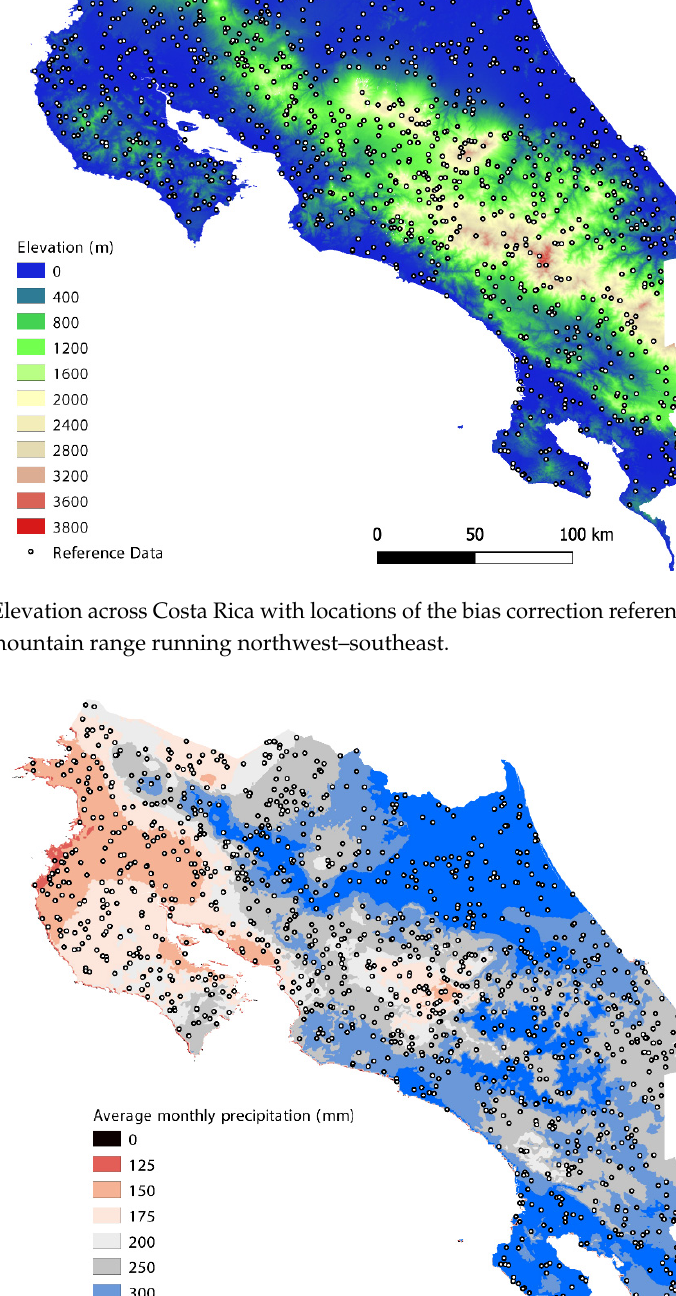
Figure A3. Scatterplot of precipitation and elevation values at reference data locations across Costa Rica. Darker colors indicate higher densities of points, and the blue vertical line indicates precipitation of 2000 mm annually ( ≈ 167 mm on average per month), which is the Holdridge threshold for the low- elevation dry forest biome.